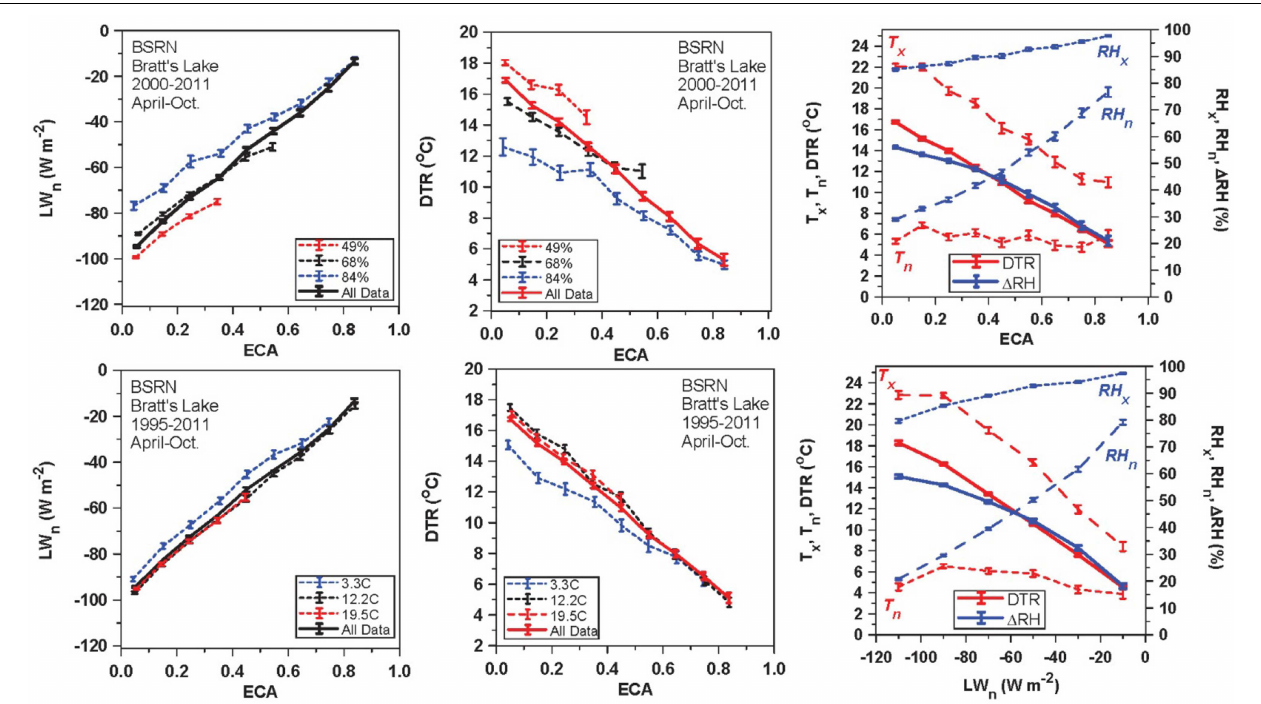
FIGURE 4 | Coupling between ECA, LW n , DTR, and 1 RH on daily timescales for April to October, for the BSRN station at Bratt’s Lake,